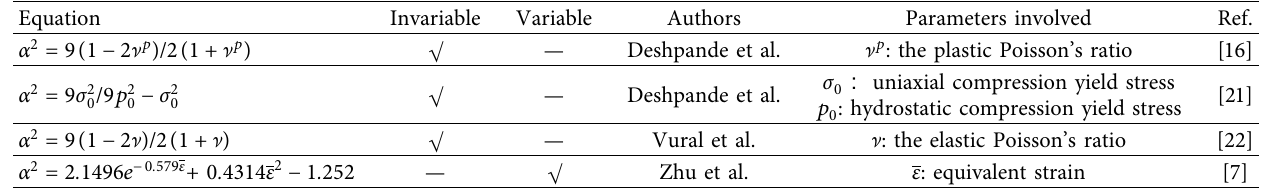
Table 1: The investigation for the ellipticity of the D-F model.